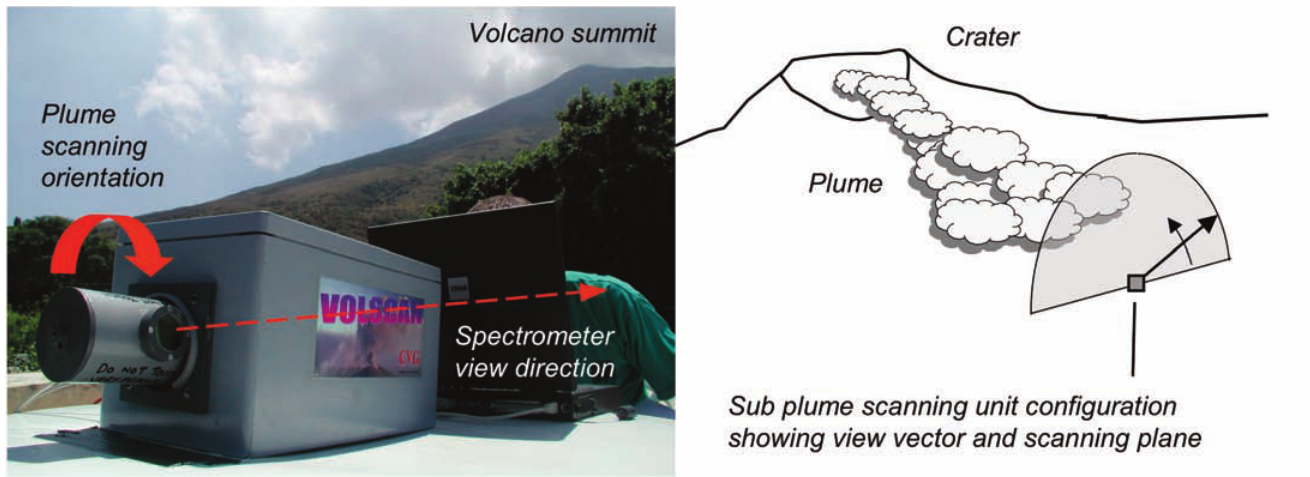
Figure 2. Left – Computer-controlled scanning unit situated beneath the plume of Stromboli volcano during SO representation of the scanning configuration, showing the scan plane inclined nearly perpendicular to the wind